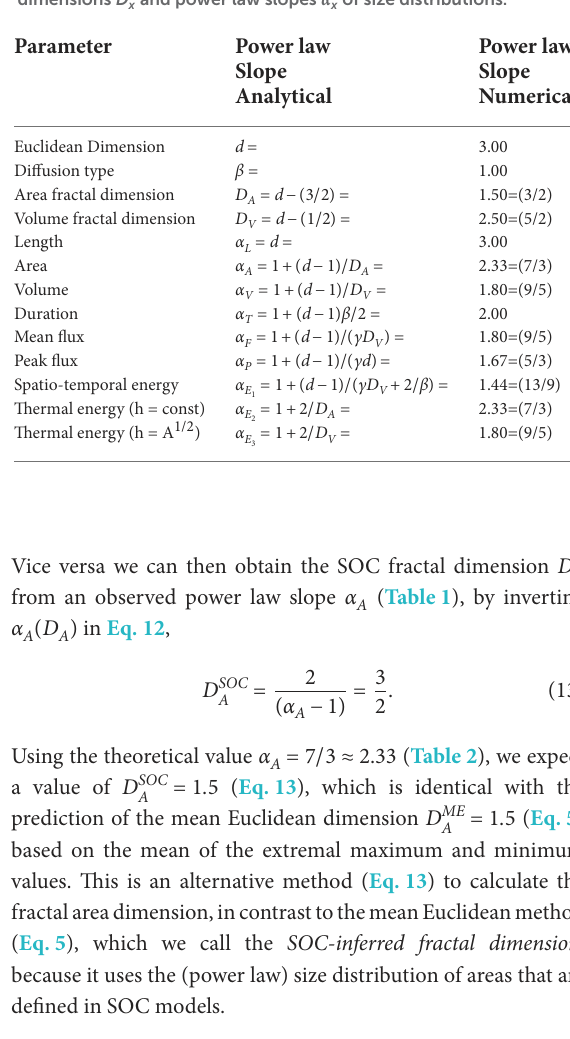
TABLE 2 Parameters of the standard SOC Model, with fractal dimensions D x and power law slopes α x of size